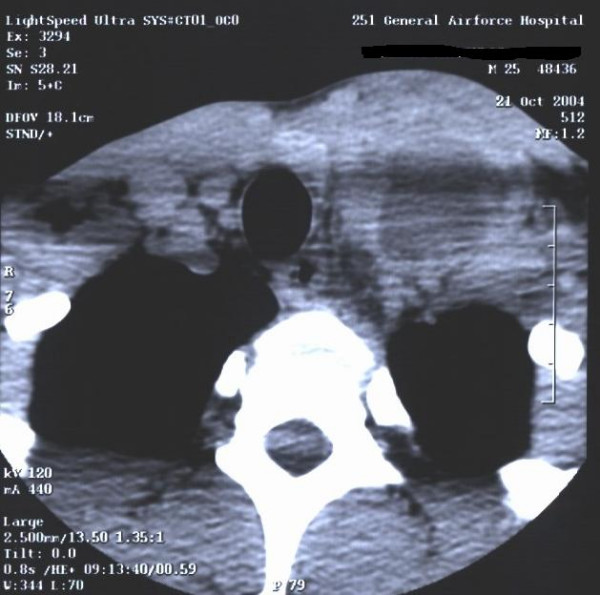
CT scan of the upper mediastinum (complementary to figure 1).